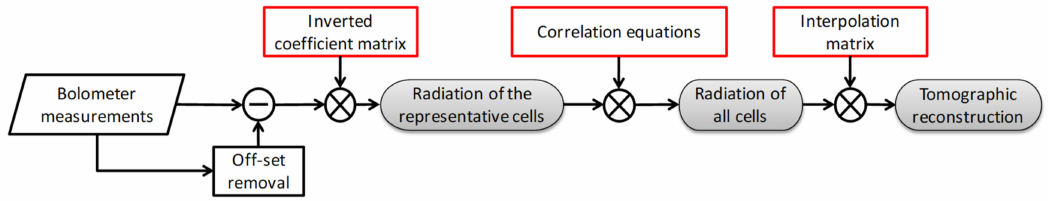
Figure 8. Online procedure scheme. In red, the inputs provided by the offline